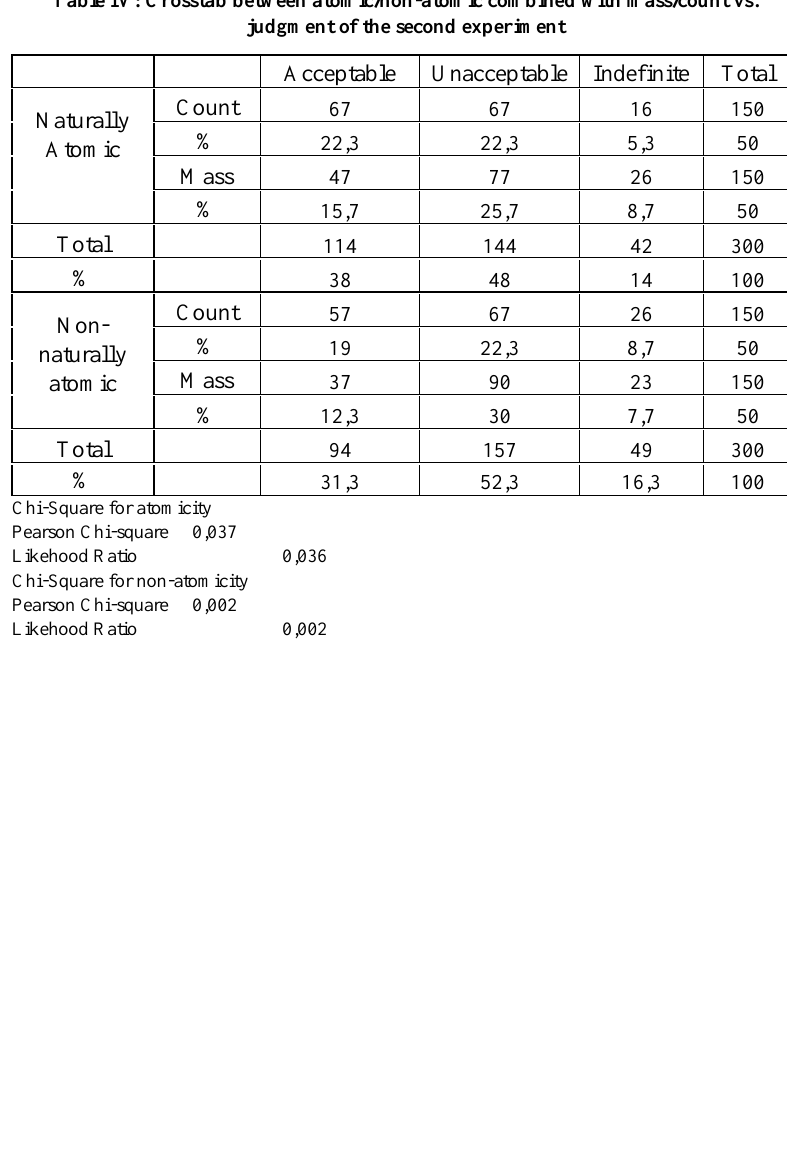
Table IV: Crosstab between atomic/non-atomic combined with mass/count